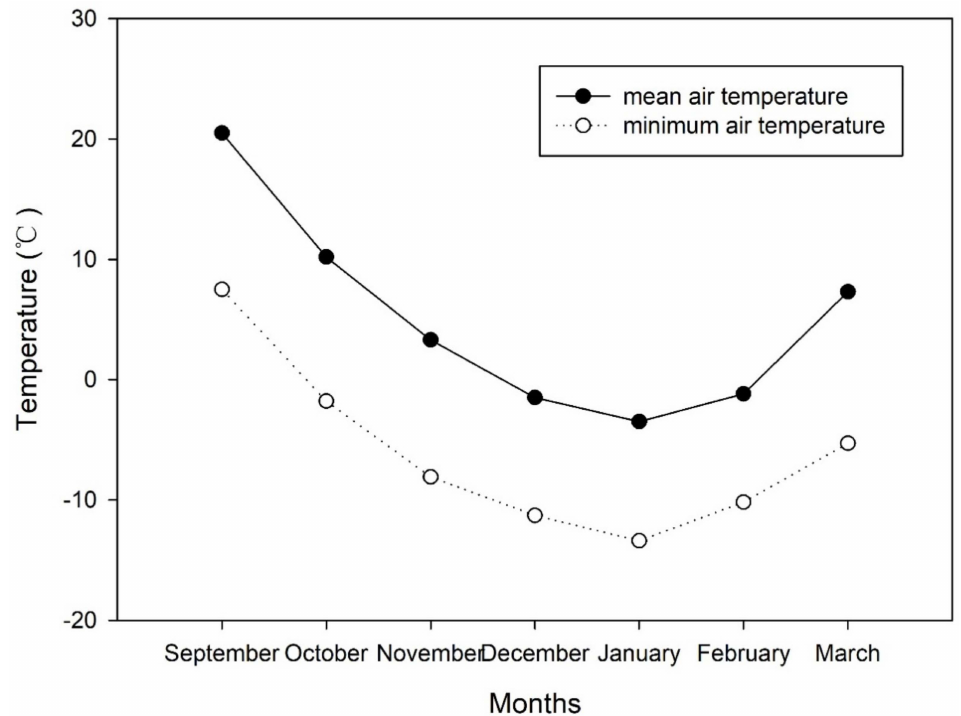
Figure2. Dynamicsofairtemperatureattheexperimentalsite(39 ◦ 48 (cid:48) N,116 ◦ 28 (cid:48) E)fromSeptember2017 to March